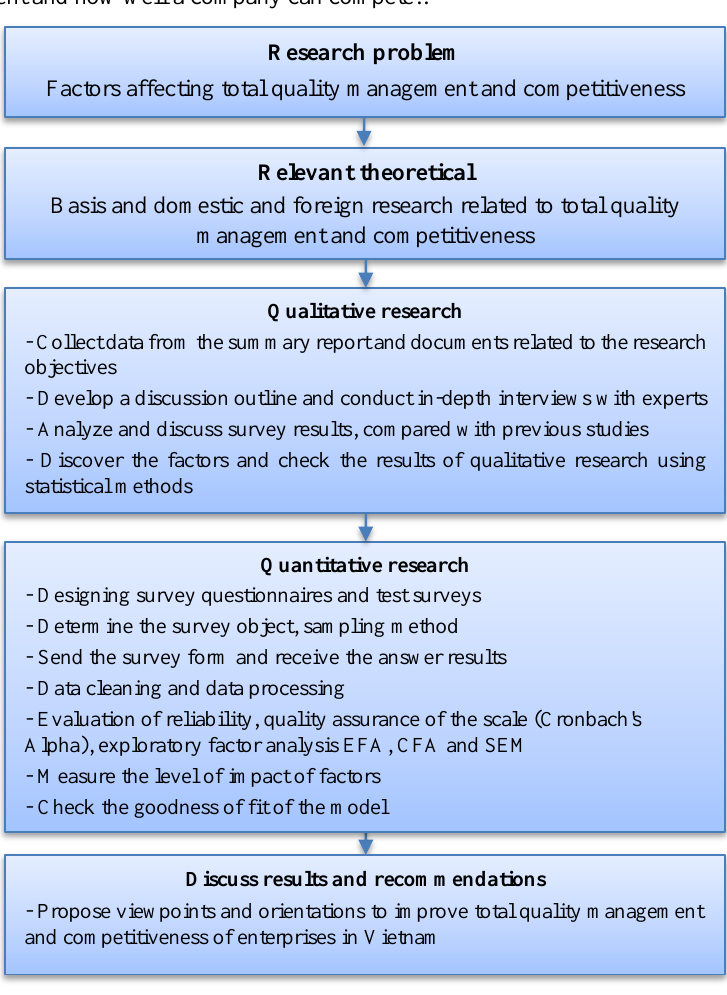
Figure 2. A research process for factors affecting total quality management and competitive capability